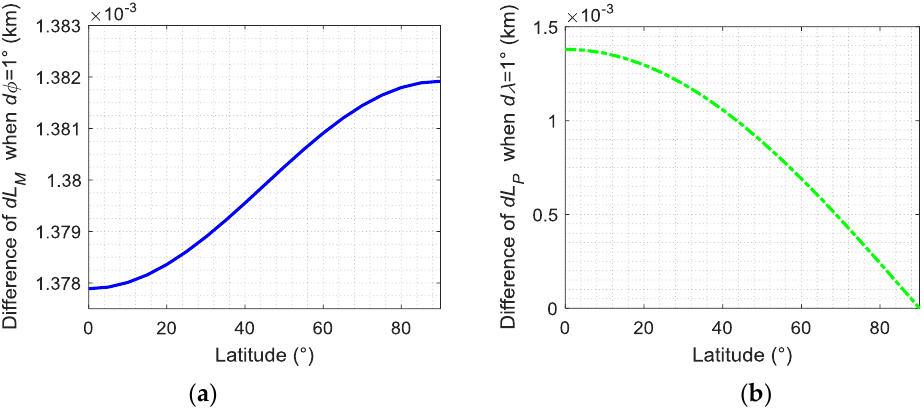
Figure A2. Difference curves about the orbital characteristics of Aqua and CloudSat, as follows: ( a ) dL M difference of Aqua and CloudSat with latitude, when d ϕ = 1 ◦ ; and ( b ) dL P difference of Aqua and CloudSat with latitude, when d λ = 1 ◦